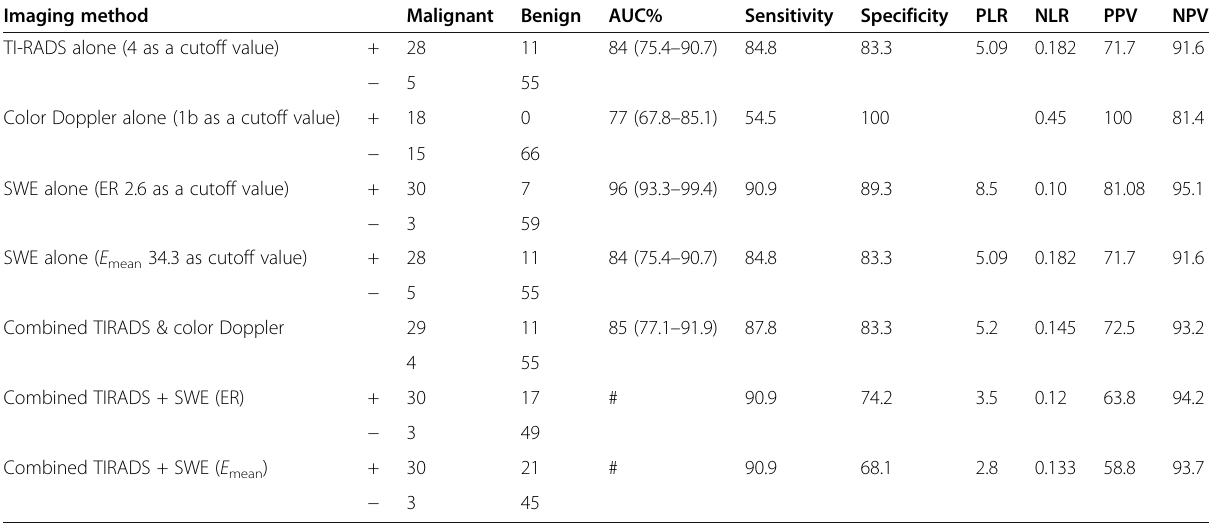
Table 9 Showing a comparison of diagnostic performance of TI-RADS alone, SWE alone, color Doppler alone, and the combined parallel